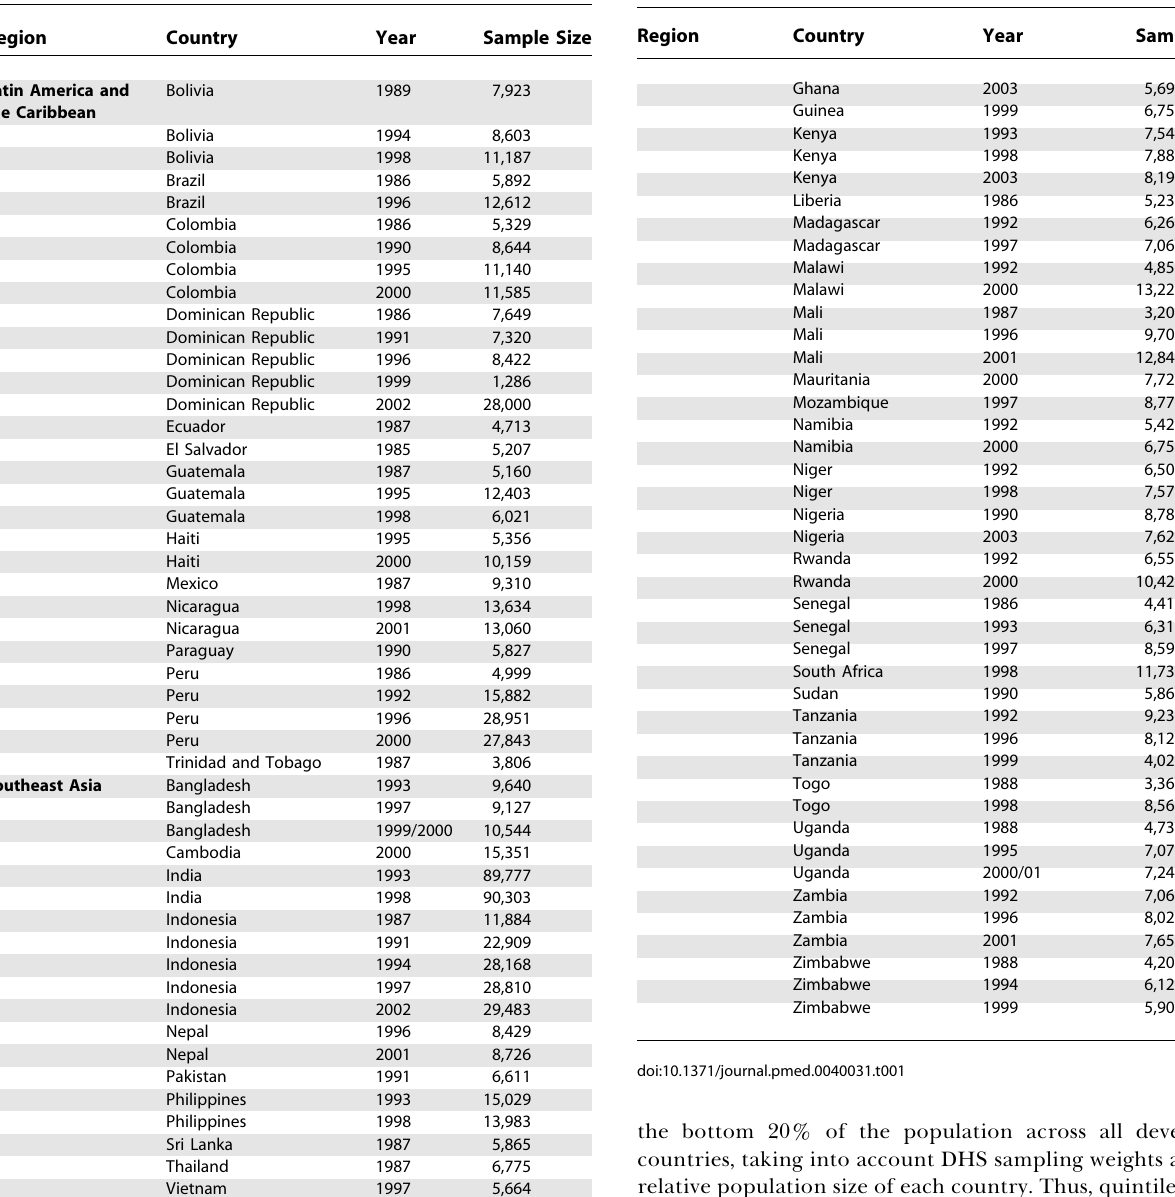
Table 1. List of Surveys Included in the